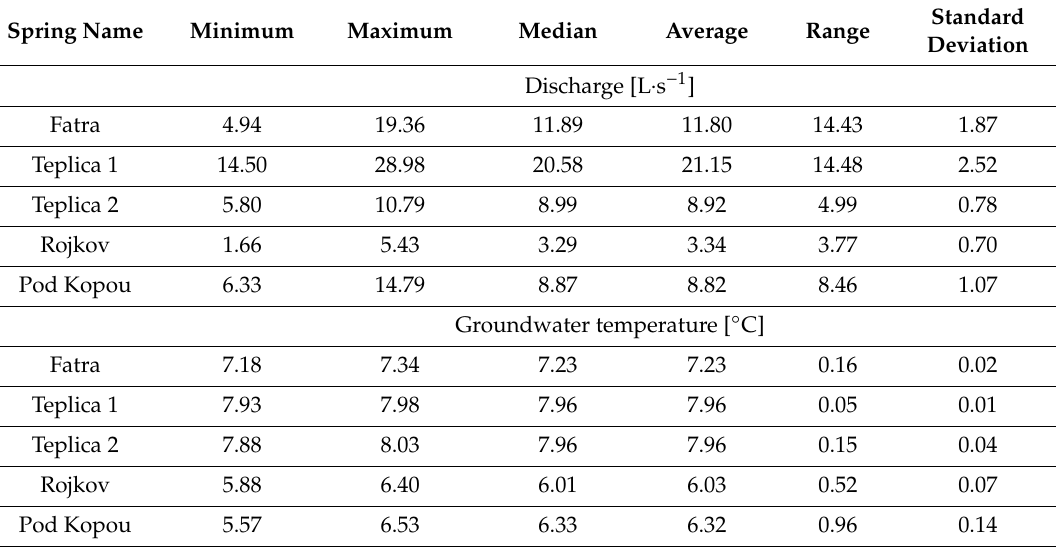
Table 6. Brief statistics of discharge and water temperature gauging results in karstic springs of the Kopa Mt. karstic